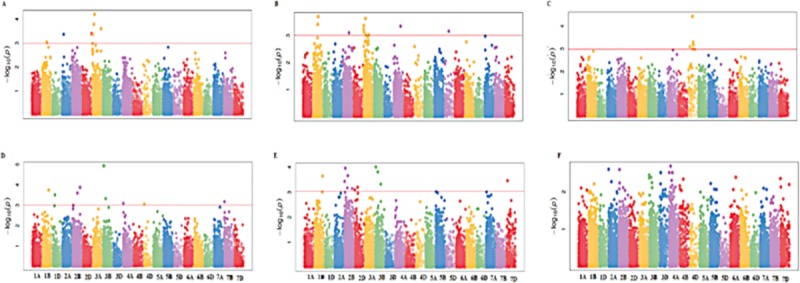
Manhattan plots showing SNP markers associated with different traits using CMLM at p-value <0.001.A. RB, B. SB and C. GY under non-stress conditions, and D. RB, E. SB and F. GY under drought-stress conditions. The horizontal red line represents FDR adjusted p< 0.001.